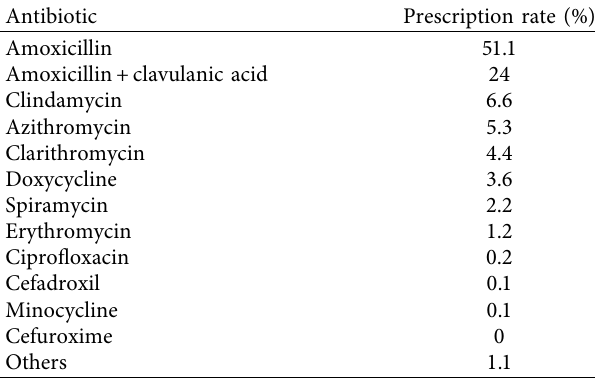
Table 1: Different rates of antibiotic prescription by dentists